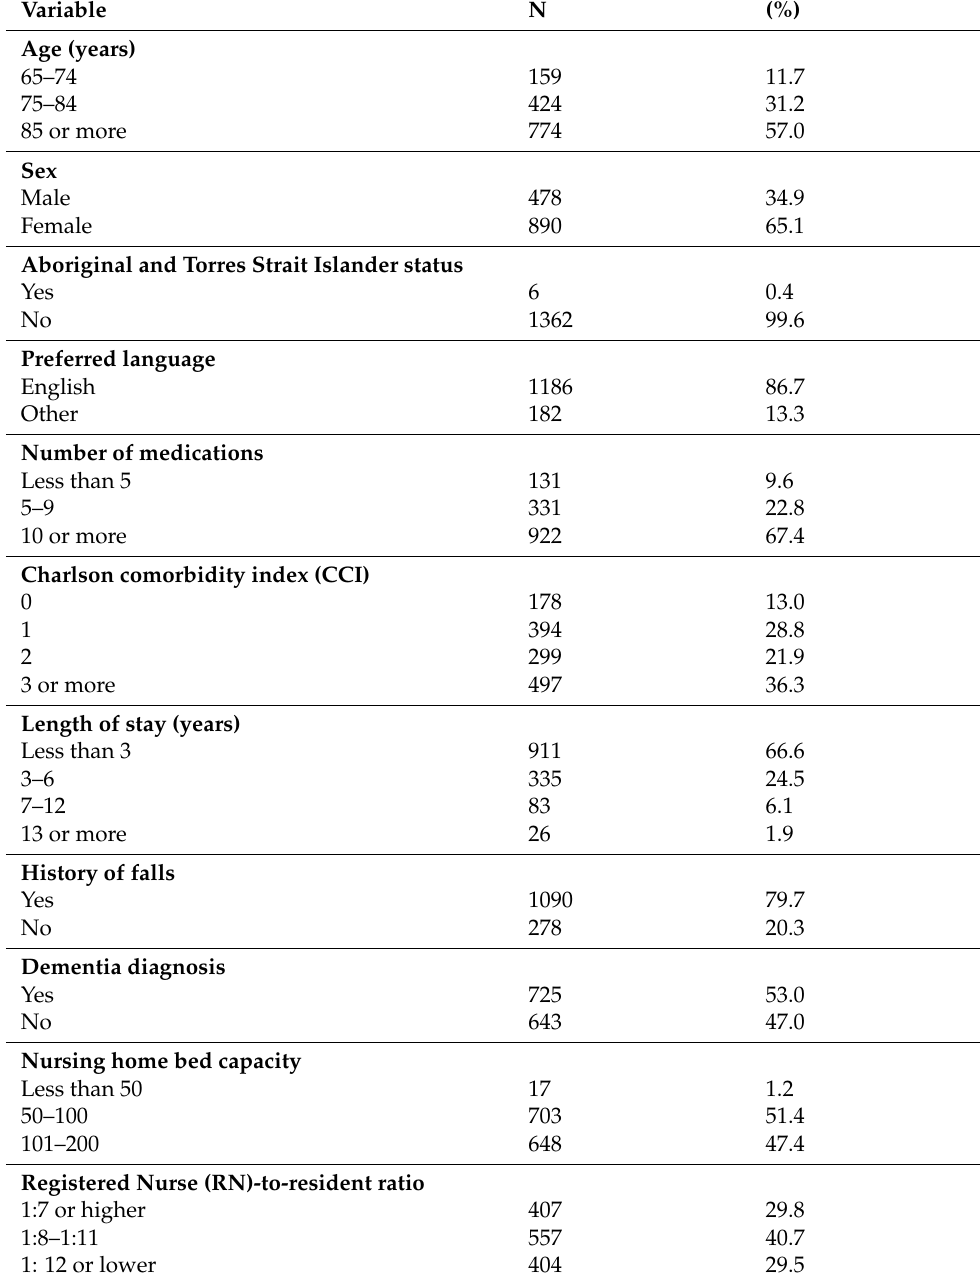
Table 1. Characteristics of